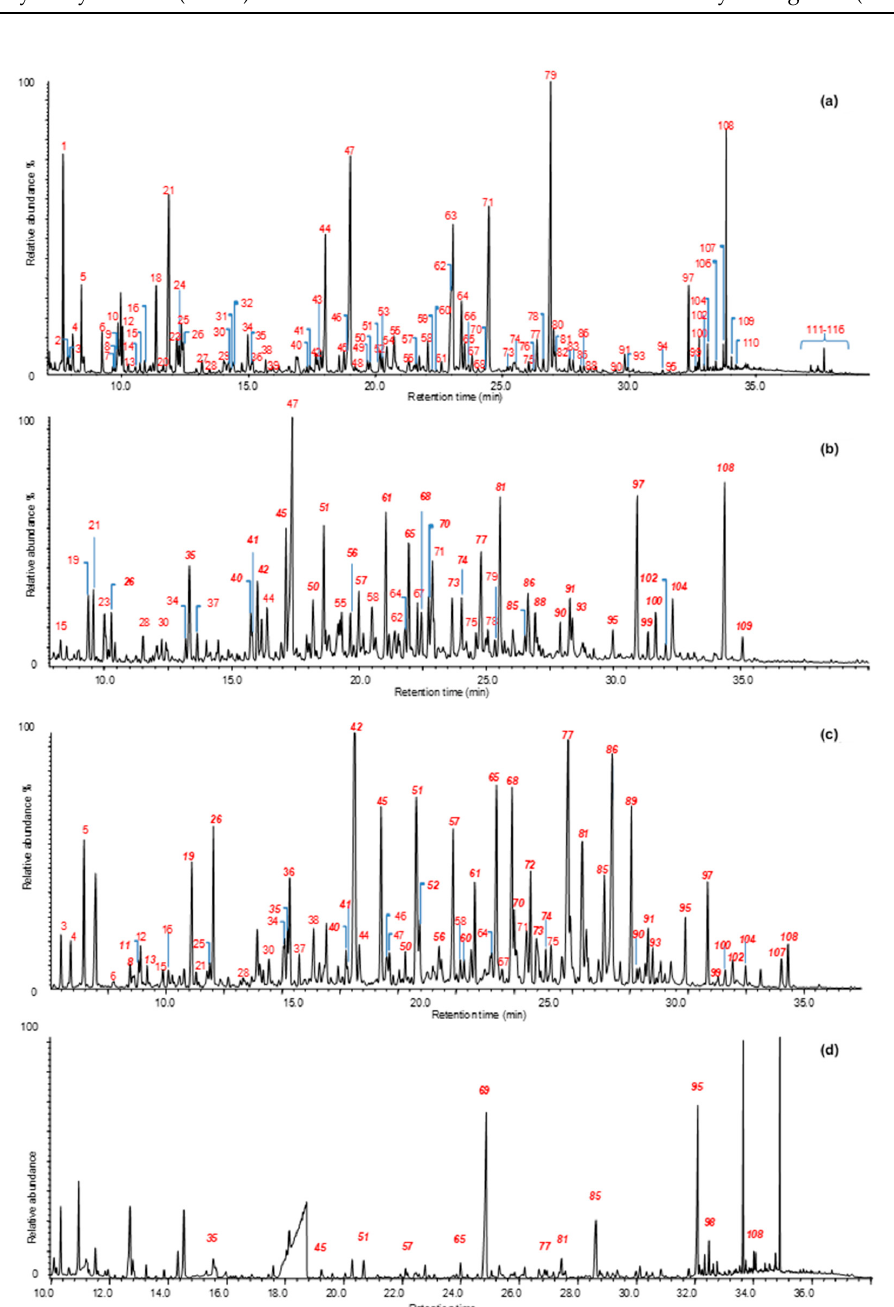
Figure 7. Py(HMDS)-GC/MS chromatographic profiles of ( a ) sound oak wood sample, ( b ) sample 4A from Biskupin [7], ( c ) sample 2212-A from La Marmotta, and ( d ) sample 185-6 from the Oseberg collection [8]. Peak labelling refers to Table 3. In Italics: Lignin pyrolysis